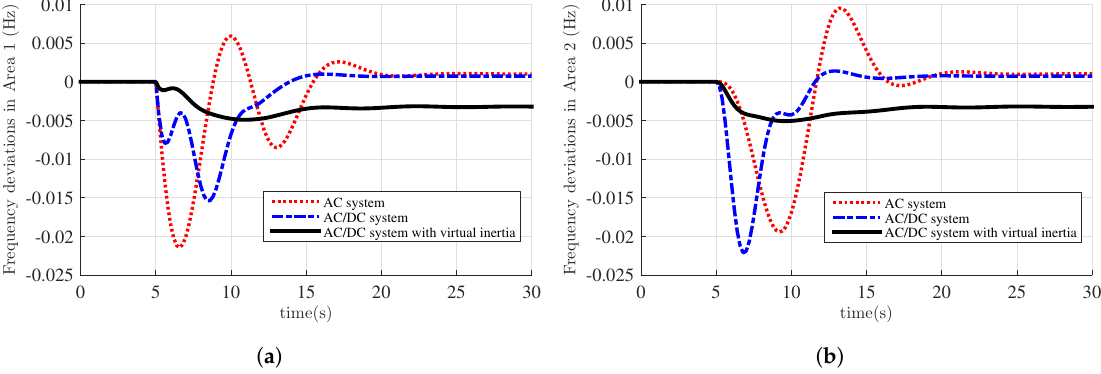
Figure 6. Case 3: results of both areas under a step-load change at 5s and also DoS attacks that start from 12s. ( a ) Frequency deviation of Area 1. ( b ) Frequency deviation of Area